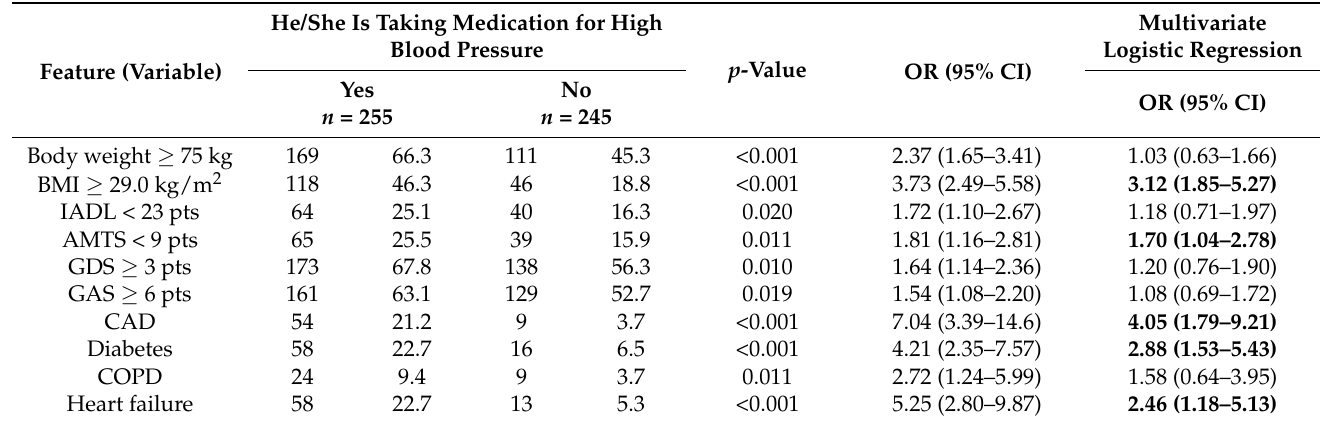
Table 5. Sociodemographic, clinical and mental characteristics in groups that differ in hypertension medication intake and test results.